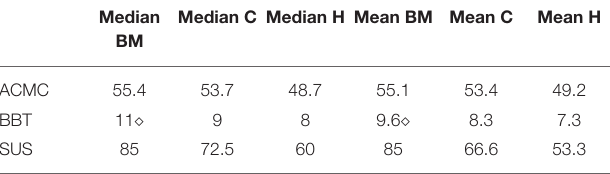
TABLE 7 | Limb loss subjects average